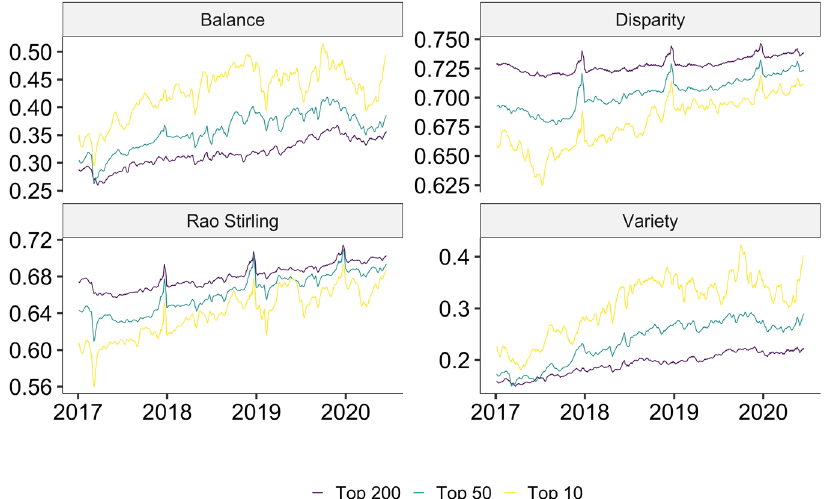
Fig. 5 Diversity of artists on Spotify. All the components of artist diversity have increased steadily during the period. As for songs, artist disparity bursts around Christmas. While balance and variety are higher at the peak of the charts, disparity shows the opposite